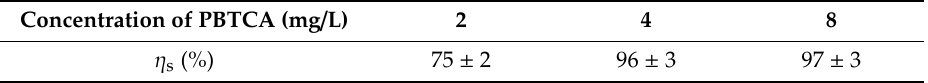
Table 1. Solution-scale-inhibition rate ( η s ) of solutions with di ff erent concentrations of PBTCA. Concentration of PBTCA (mg /